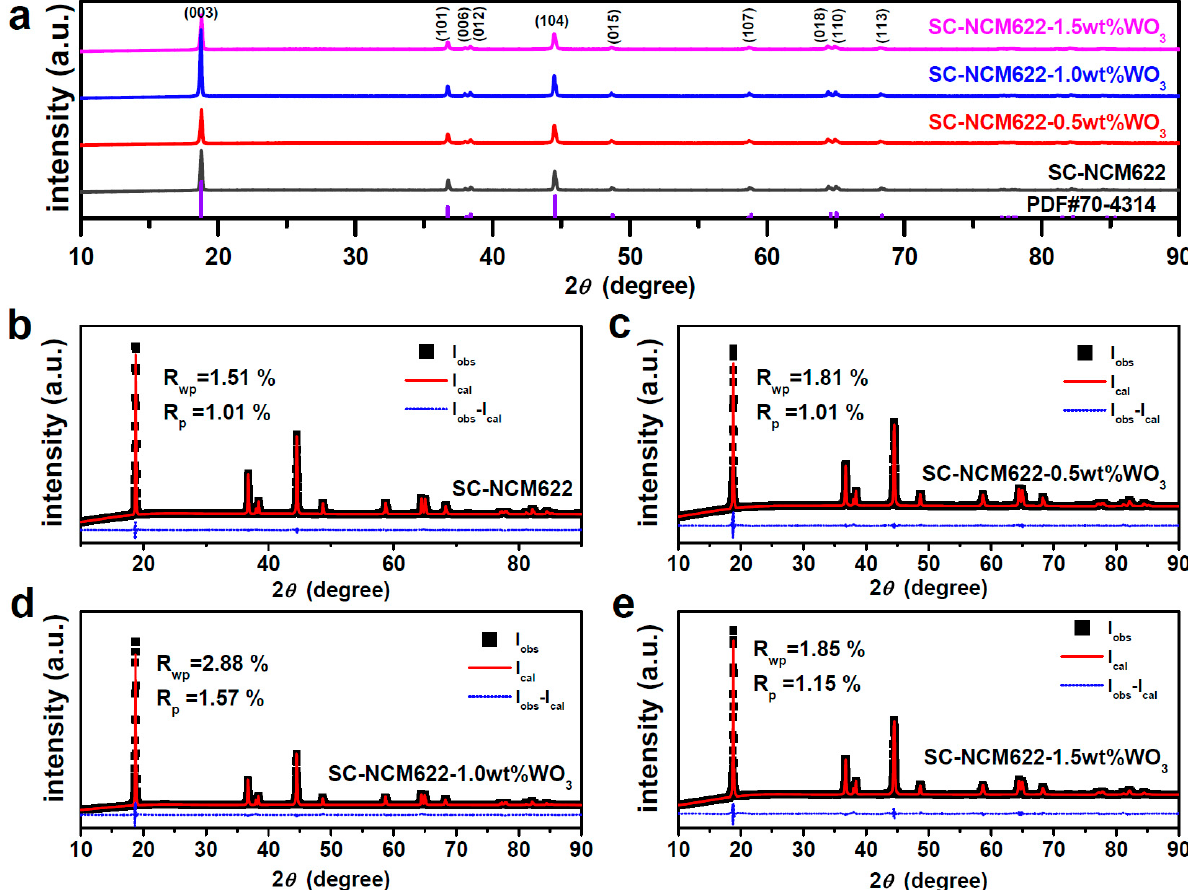
Figure 1. ( a ) X-ray diffraction patterns of the samples, and Rietveld refinement results for ( b ) SC-